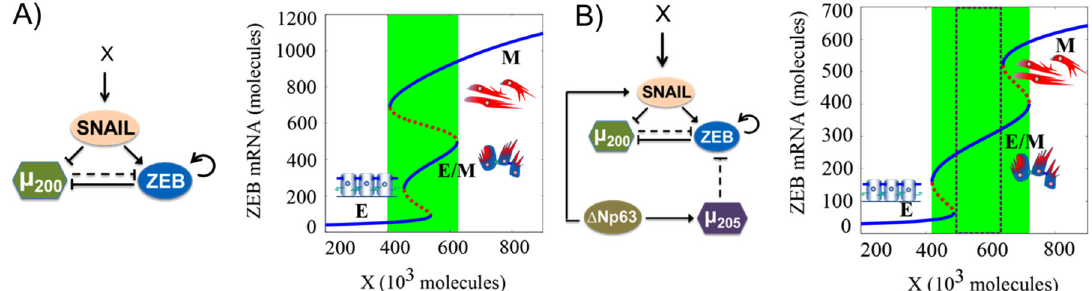
Fig. 3 Dynamical system characteristics for miR-200/ZEB/SNAIL and miR-200/ZEB/SNAIL/ Δ Np63 α /miR-205 circuits. Bifurcation levels of ZEB1 mRNA in response to an external signal X driving a miR-200/ZEB/SNAIL, and b miR-200/ZEB/SNAIL/ Δ Np63 α /miR-205, representing the response of different circuits to varying levels of an EMT-inducing signal (shown as X). Solid blue curves denote stable states (phenotypes), while red dotted curves denote unstable states. Lower ZEB mRNA levels ( < 150 molecules) represent an epithelial (E) state, intermediate ZEB mRNA levels (~ 200 – 400 molecules) correspond to a hybrid E/M state, and higher ZEB mRNA levels ( > 500 molecules) denote a mesenchymal (M) state. Cartoons have been added alongside for the corresponding phenotypes. For low levels of X, cells can attain only an E state. With increasing levels of X, cells can undergo partial EMT to attain a hybrid E/M state. Further increase in X drives a complete EMT to a M state. The region marked in green represents the range of levels of X for which the hybrid E/M phenotype can exist as one of the multiple possible phenotypes; and that marked by dotted rectangle denotes the levels of X for which the hybrid E/M phenotype can exist alone. Note that the introduction of a ‘ phenotypic stability factor (PSF) ’ such as Δ Np63 α has dramatically broadened the allowable range for a hybrid E/M phenotype. More importantly, it enabled the existence of a region where most cells can maintain a hybrid E/M state stably, i.e., a fl ow cytometry analysis of the region shown in dotted rectangle will identify that most cells co-express epithelial and mesenchymal markers, thereby displaying a hybrid E/M phenotype. Details of the mathematical models for both these circuits used to obtain these bifurcation diagrams are given in the Supplementary